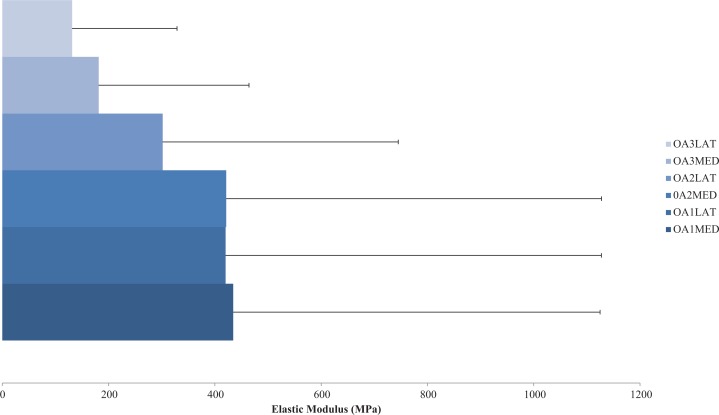
Compressive elastic modulus of subchondral bone in osteoarthritis.Compressive axial elastic modulus of subchondral bone for a range of osteoarthritis (OA) grades (1–3). Average elastic modulus decreases with degenerative grade in the medial (MED) and especially lateral (LAT) compartments. (Redrawn from Zysset, Sonny & Hayes (1994): Elsevier License Permission: 4226540285665).